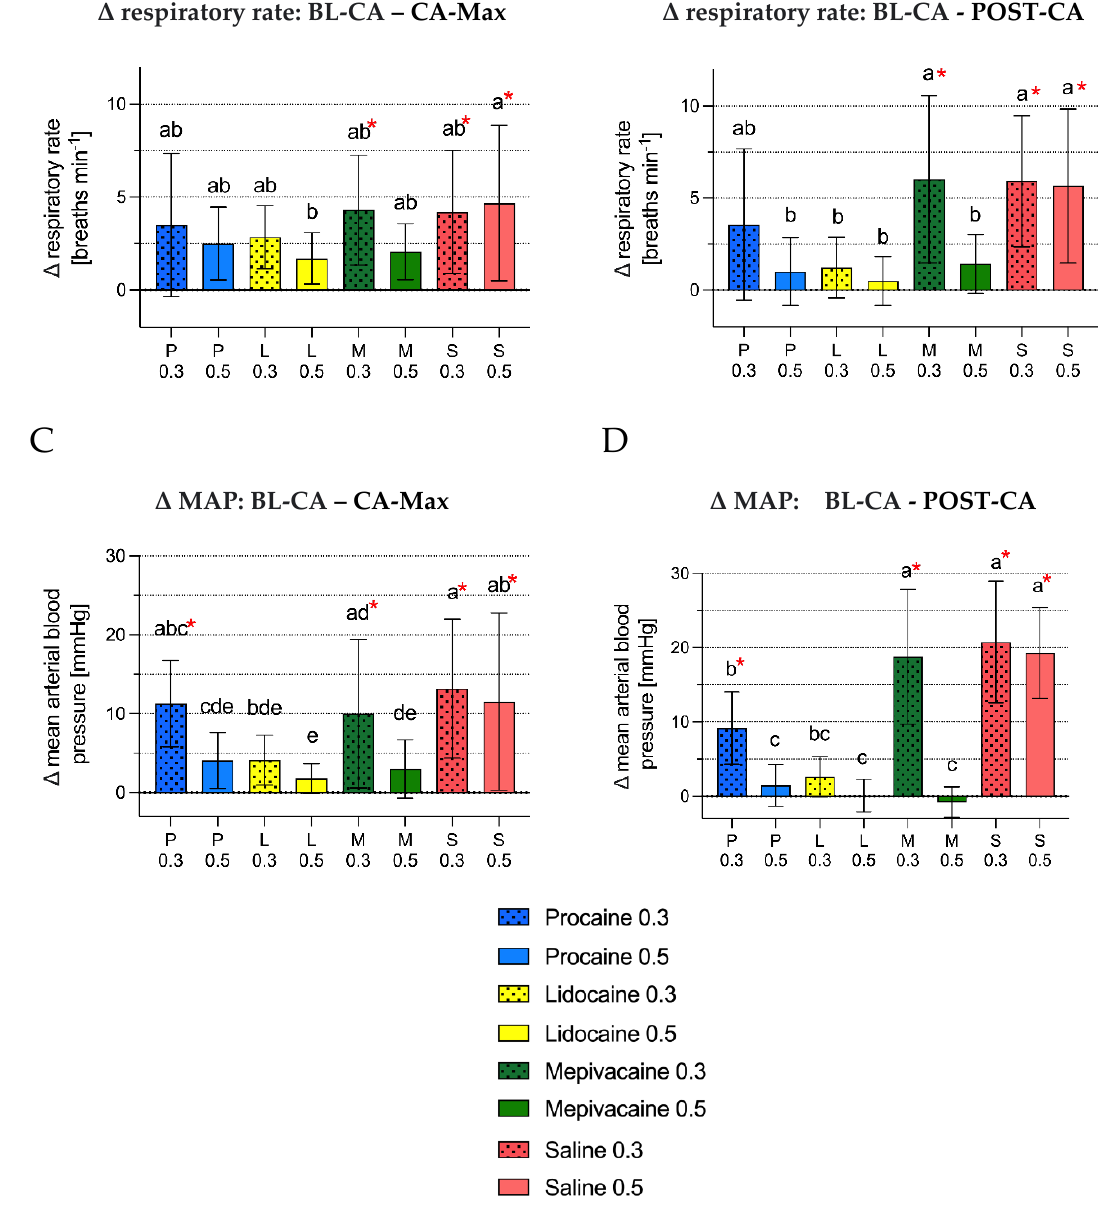
Figure 7. ( A – D ) Mean (SD) difference ( Δ ) in respiratory rate and mean arterial blood pressure between baseline and during castration and between baseline and post castration in the experimental groups. Bar diagrams of ( A ) mean difference ( Δ ) in respiratory rate [breaths minute −1 ] between baseline and maximum respiratory rate during castration and ( B ) between baseline and post castration as well as bar diagrams of ( C ) mean difference in mean arterial blood pressure (MAP) [mmHg] between baseline and maximum MAP during castration and ( D ) between baseline and post castration. The bar indicates the mean and standard deviation is represented by the whiskers. Different letters (a, b, c, d, e) show significant differences between the experimental groups ( p < 0.05). The red asterisk (*) marks an increase above 10% from baseline.